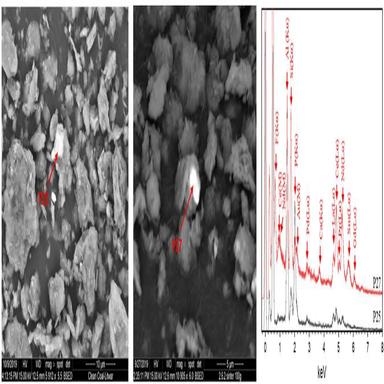
EDX spectra of the enriched-phosphate REE-bearing particles (P25 and P27) found in SP25-F1.